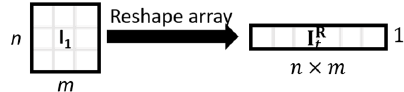
Figure 7. Diagram of the image matrix converted into one-dimensional vectors.